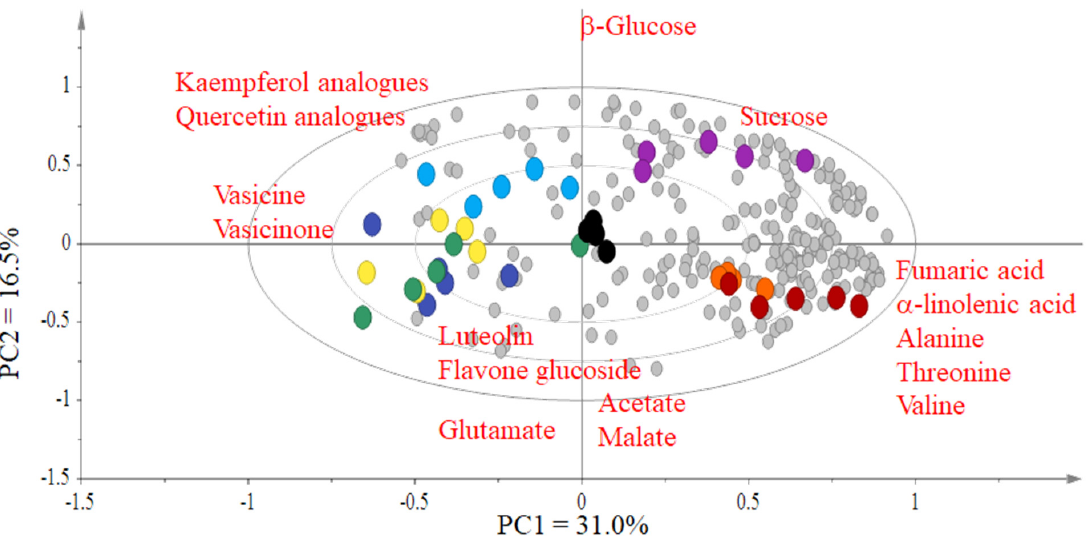
Figure 3. Biplot of Principal Component Analysis (PCA) (R2/Q2 = 0.787/0.541) for the NMR spectral data of the samples from the different regions: Adhatoda vasica leaves from various regions (Abbottabad ● , Muzaffarabad ● , Haripur ● , Gazi ● , Taxila ● , Rawalpindi ● , Havelian ● , Khanpur ● , NMR shifts of metabolites ● .)